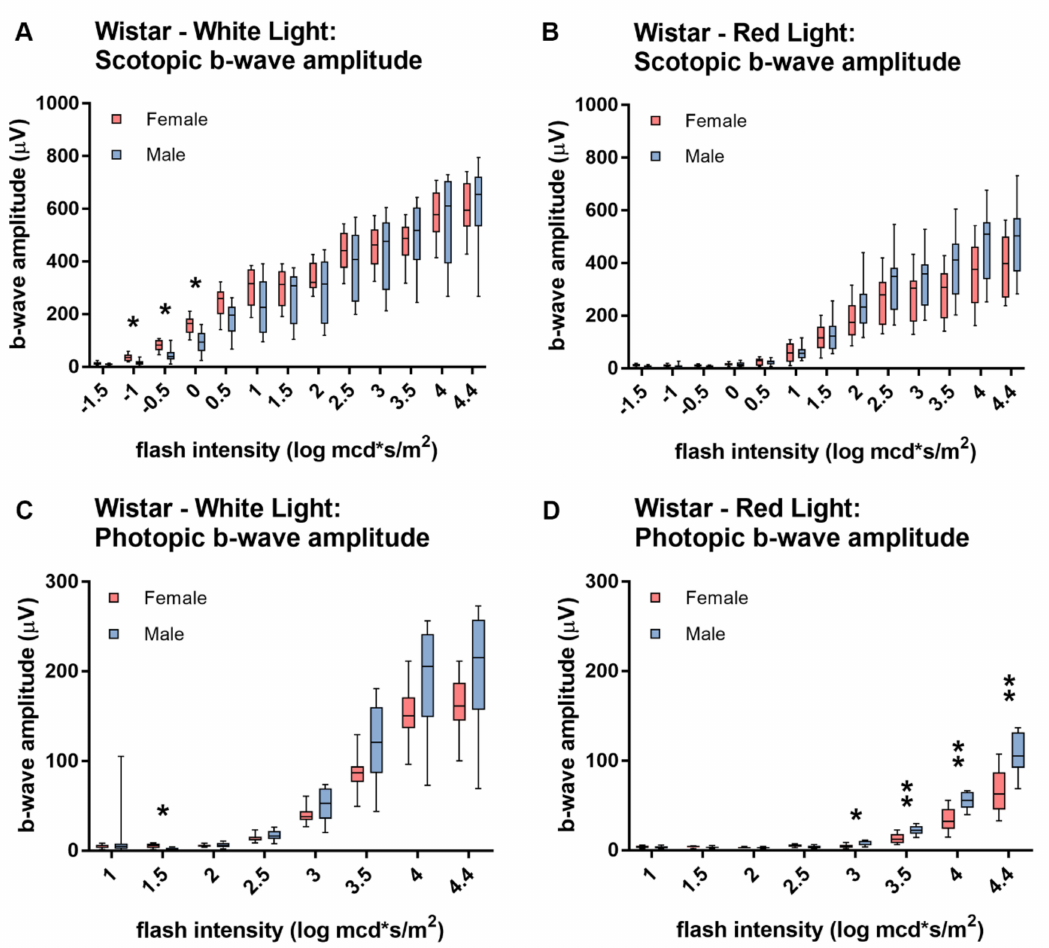
Figure 6. Sex-dependent di ff erences in white- and red-light ERG responses in Wistar rats. Female Wistar rats have a slightly significantly higher scotopic white-light evoked b-wave amplitude at dim-light intensities ( A ). If stimulated with red light, there is no significant sex difference in scotopic b-wave amplitudes ( C ). There is a tendency of male Wistar rats showing a larger photopic ( B , D ) ON-response to bright light than female rats. This is statistically significant for red light ( D ), however not for white light (B). Statistics: t-test corrected with Holm-Sidak method for multiple comparisons. * p ≤ 0.05, ** p ≤